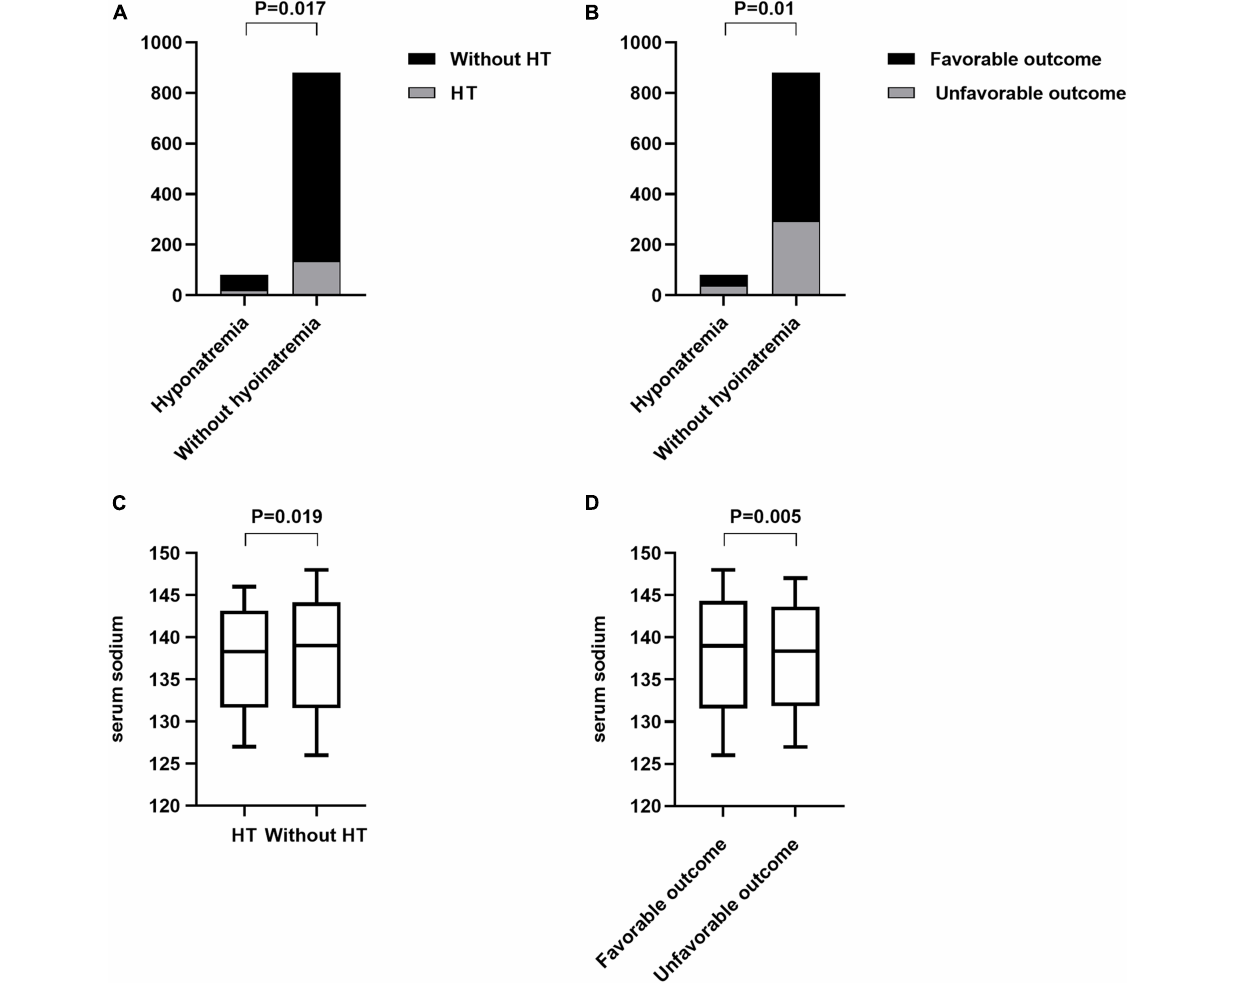
FIGURE 2 | Comparison of the endpoints between patients with and without hyponatremia and the comparison of serum sodium levels between different endpoint groups. (A) Incidence of HT between hyponatremia and without hyponatremia groups (25.6% vs. 15.4%, p = 0.017). (B) Incidence of the poor 3-month outcome between patients with and without hyponatremia (46.7% vs. 33.4%, p = 0.01). (C) Comparison of the serum sodium levels between the HT and without HT groups {138.4 [136.4–140.3, interquartile range (IQR)] vs. 139.0 (137.2–140.7, IQR) mmol/L, p = 0.019}. (D) Comparison of the serum sodium levels between the different prognosis groups [139.0 (137.2–140.7) vs. 138.4 (136.7–140.3) mmol/L, p =